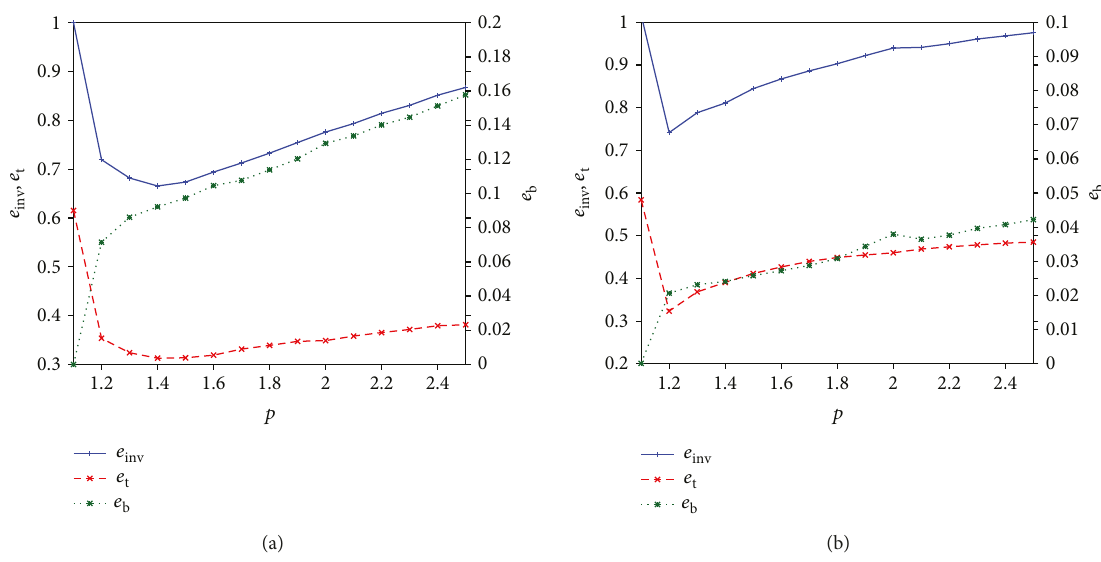
Figure 13: Behaviour of the reconstruction errors versus the norm parameter p . (a) TwoSpheres and (b) TwoCubes targets.